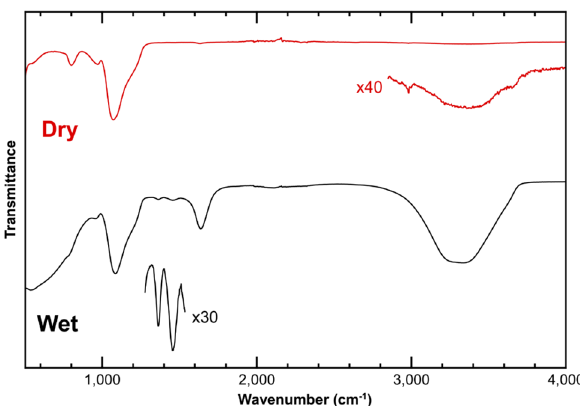
Figure 3. FT-IR spectra of a wet gel (black curve) and dried silica aerogel (red curve). The magnified region of the wet gel spectrum shows IR modes associated with the HCO 3− and NH 4+ ions , whilst that of the dry aerogel shows the –OH stretching region of